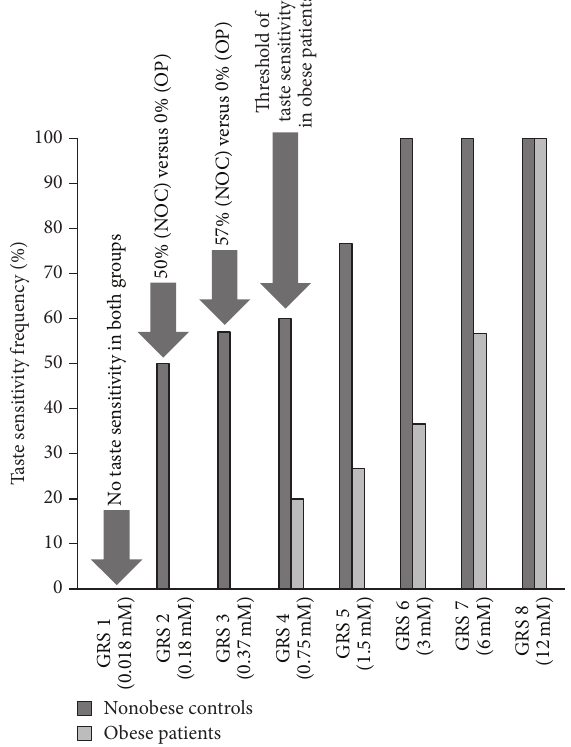
Figure 4: Threshold of taste sensitivity in obese patients and con- trols. Fat’s detection thresholds in nonobese controls are perceptible starting from the second GRS, while obese patients could not taste fat before the fourth GRS. NOC: nonobese controls, OP: obese patients, and GRS: gustatory response